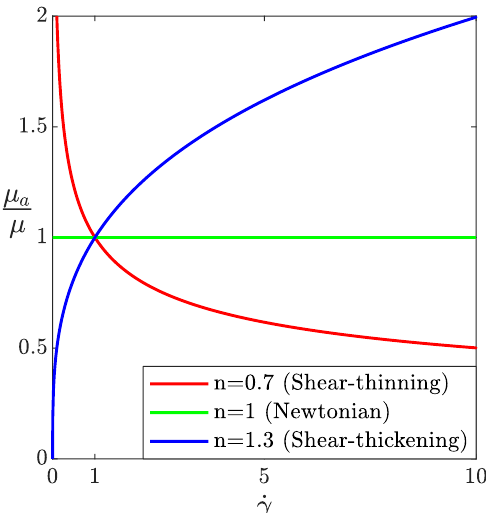
Figure 1. Apparent dynamic viscosity µ a , normalized with the viscosity of the Newtonian fluid µ , as a function of the shear rate ˙ γ